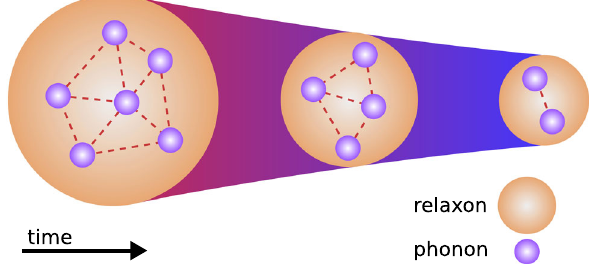
FIG. 1. Schematic illustration of the equilibration of lattice vibrations after a thermal excitation. Each relaxon consists of a linear combination of phonons, which interact through scattering events among themselves but are decoupled from phonons belonging to different relaxons. The relaxon decays exponentially to equilibrium, where it disappears at a rate determined by its relaxation